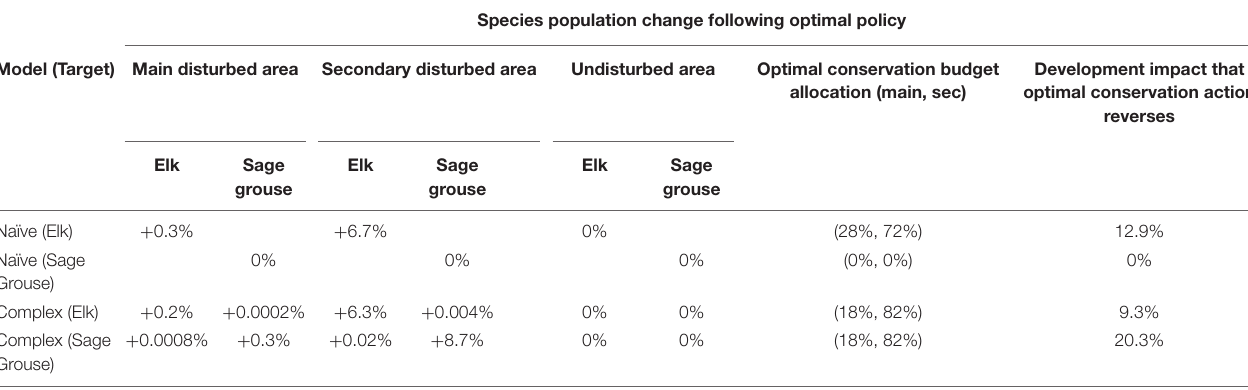
TABLE 2 | Impact on the species populations of conservation actions that reduce